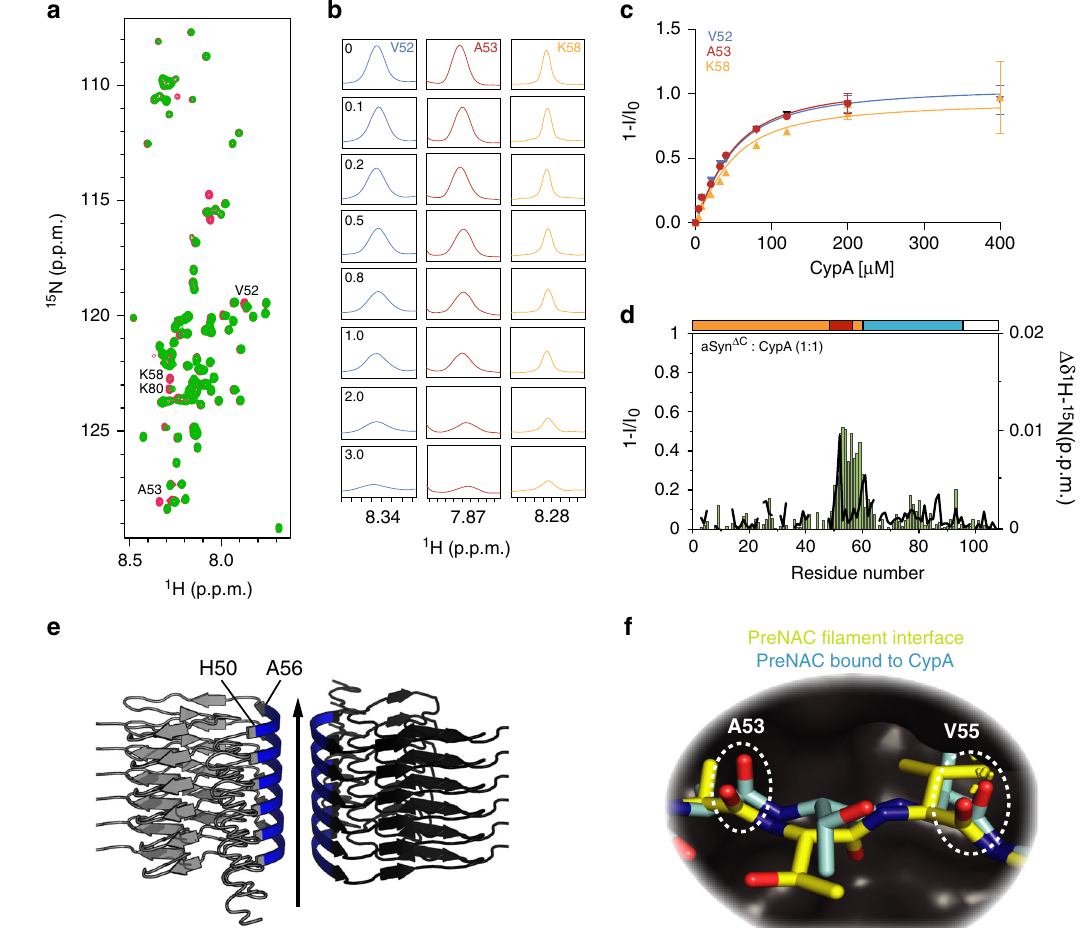
Fig. 6 CypA captures aSyn residues important for fi lament-interface formation. a Superposition of 1 H – 15 N HSQC spectra of aSyn Δ C in the absence (red) and presence (green) of fi vefold excess of CypA. b One-dimensional 1 H traces through selected cross-peaks of 1 H – 15 N HSQC spectra of aSyn Δ C in the presence of increasing concentrations of CypA. CypA:aSyn Δ C molar ratios are indicated in the panels of V52. c Intensity changes of residues in aSyn Δ C